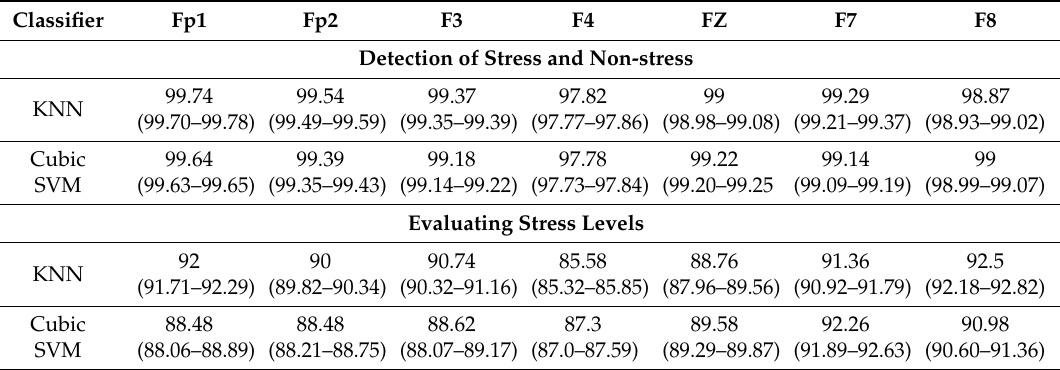
Table 7. Accuracy (%) with (95% CI) for detecting stress and non-stress, and evaluating stress levels using each frontal electrode individually using five-folds cross